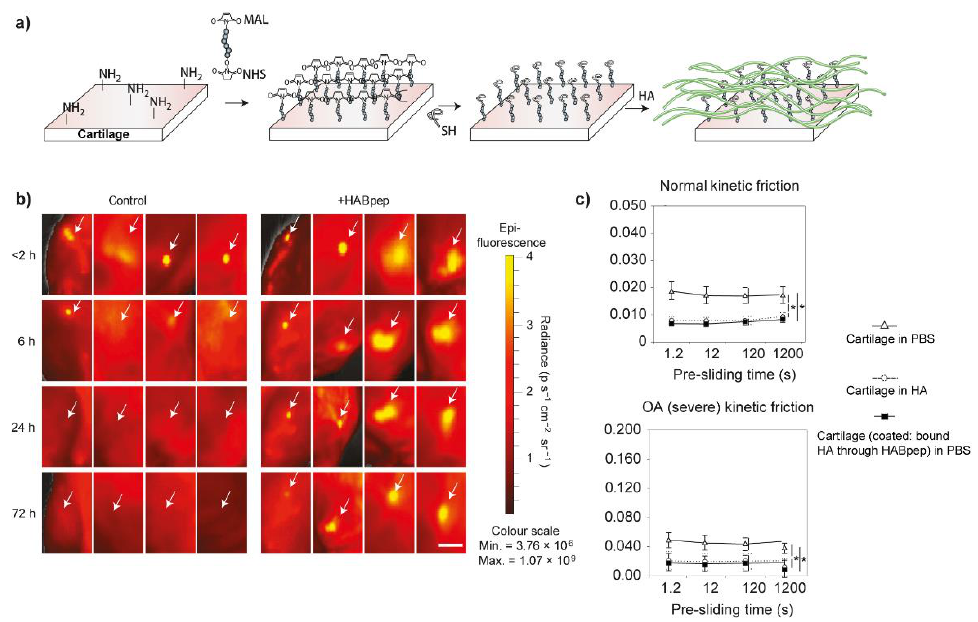
Figure 4. ( a ) Schematic process of cartilage-surface modification of peptide-polymer HABpep to arrest HA in the surrounding synovial fluid. MAL-PEG-NHS, as a crosslinker, was firstly reacted with the exposed primary amines in cartilage surface and then subsequently reacted with the thiolated HABpep by click reaction to prepare a coating that can recruit HA to the surface of the cartilage. ( b ) After modified the cartilage surface with HABpep, the HA molecules tagged with rhodamine (White arrows) were retained within the joint for 72 h post articular injection, whereas, the retention time of HA was only 6 h without this coating. Scale bar, 1 cm. ( c ) The kinetic friction coefficients of normal cartilage samples (upper) and severe OA cartilage samples (lower) with or without modification. Reprinted with permission from ref. [97]. Copyright 2014 Springer Nature.